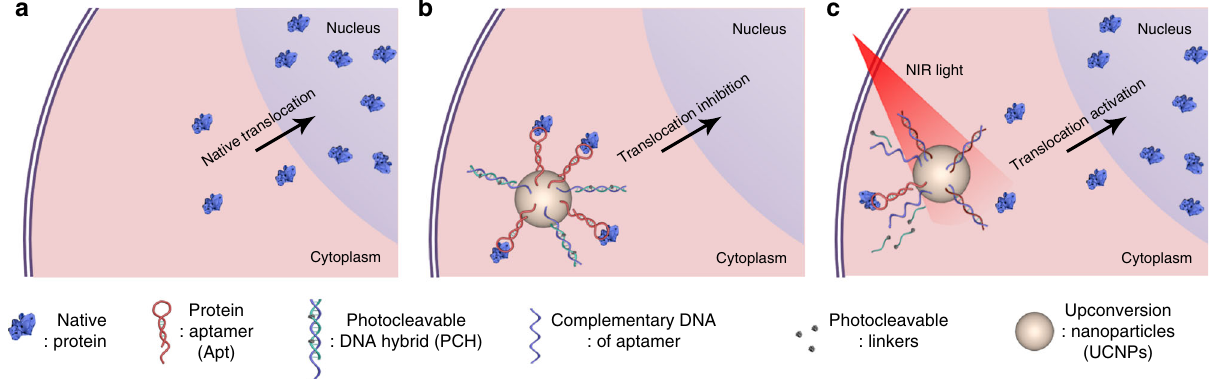
Fig. 1 Schematic illustration of the aptamer-based NIR-responsive nanoplatform for manipulating the subcellular localization of native protein in living cells. a Translocation behavior of proteins from cytoplasm to nucleus. b Protein-speci fi c aptamers (Apt) and photocleavable DNA hybrid (PCH 2 ) are functionalized onto the surface of UCNPs. After internalization into the cytoplasm, PHC 2 -Apt-UCNPs can speci fi cally capture target proteins and inhibit their subcellular traf fi cking behavior. c Based on the capability of UCNPs for transforming NIR light excitation into UV light emission, PHC 2 can be activated to compete Apt from the Apt/protein binding complex upon NIR laser irradiation. In this way, proteins can be released to restore their natural